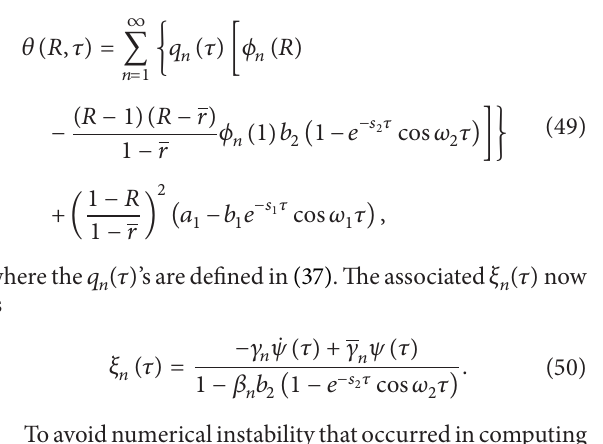
Figure 2: Temperature distribution and variation along the radial of the hollow cylinder with different parameter 𝑠 1 of temperature